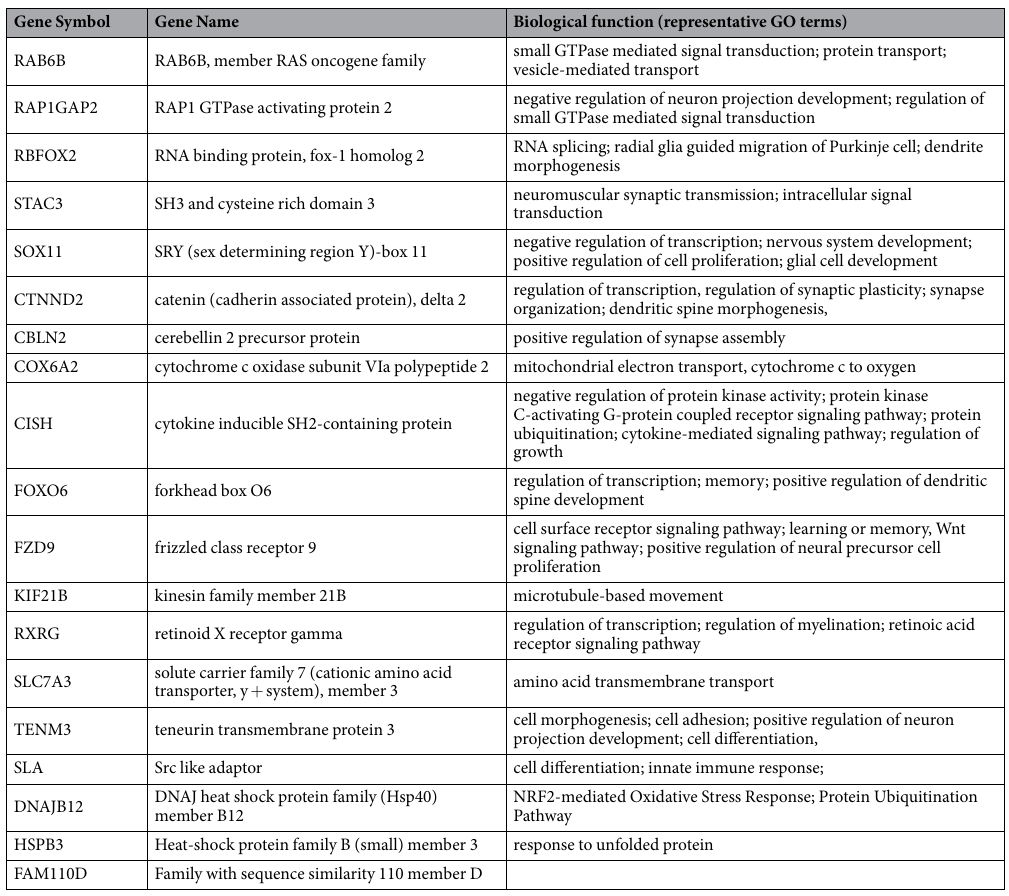
Table 3. Neuron-enriched genes that showed increased levels during late stages of